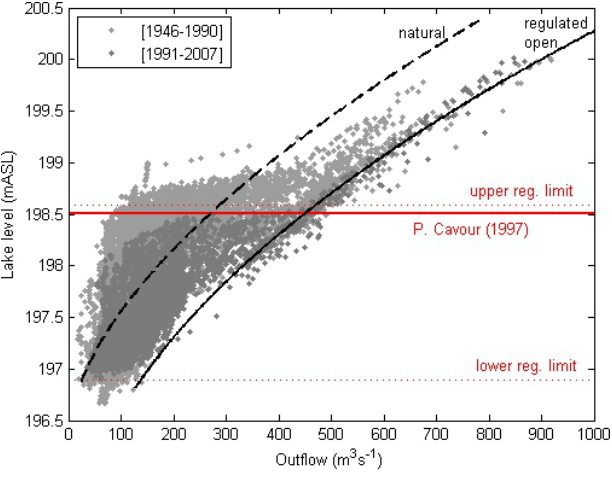
Fig. 5. Daily data of outflow discharge (m 3 s -1 ) plotted against lake level (m ASL) from 1946 to 1990 (light gray) and from 1991 to 2007 (dark gray, covers some light gray data points); dashed black line: rating curve for Lake Como in natural conditions (before construction of the dam in 1946); plain black line: rating curve for Lake Como in regulated conditions, all dam gates open (free regime); dotted red lines: regulation range; plain red line: lowest elevation of Piazza Cavour measured in 1997 (Comerci et al. 2007). Rating curves were elaborated by the Hydrographic Office of the Po River and reported by Moisello and Vullo